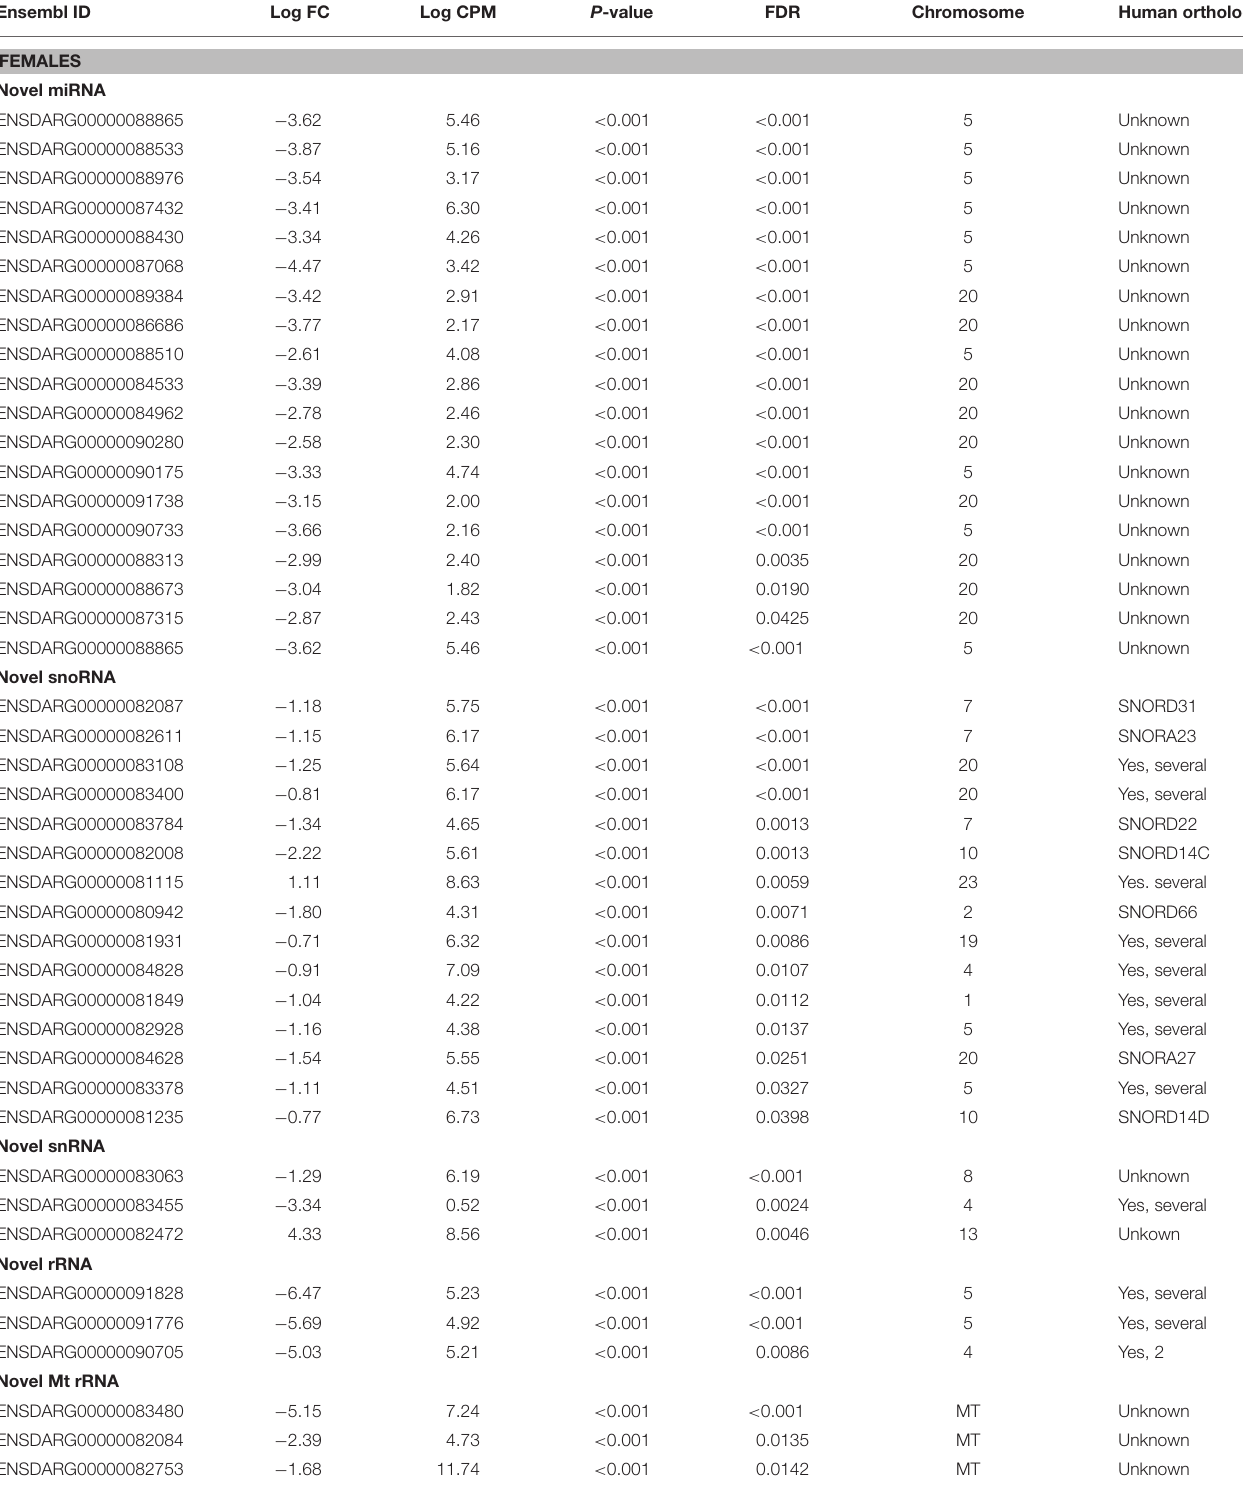
TABLE 6 | List of non-coding genes significantly affected in brains of zebrafish developmentally exposed to 3ng/L (males) and 10ng/L (females) EE 2 compared to non-exposed fish after 120 days of recovery in clean water. Ensembl ID Log FC Log CPM P -value FDR Chromosome Human ortholog FEMALES Novel